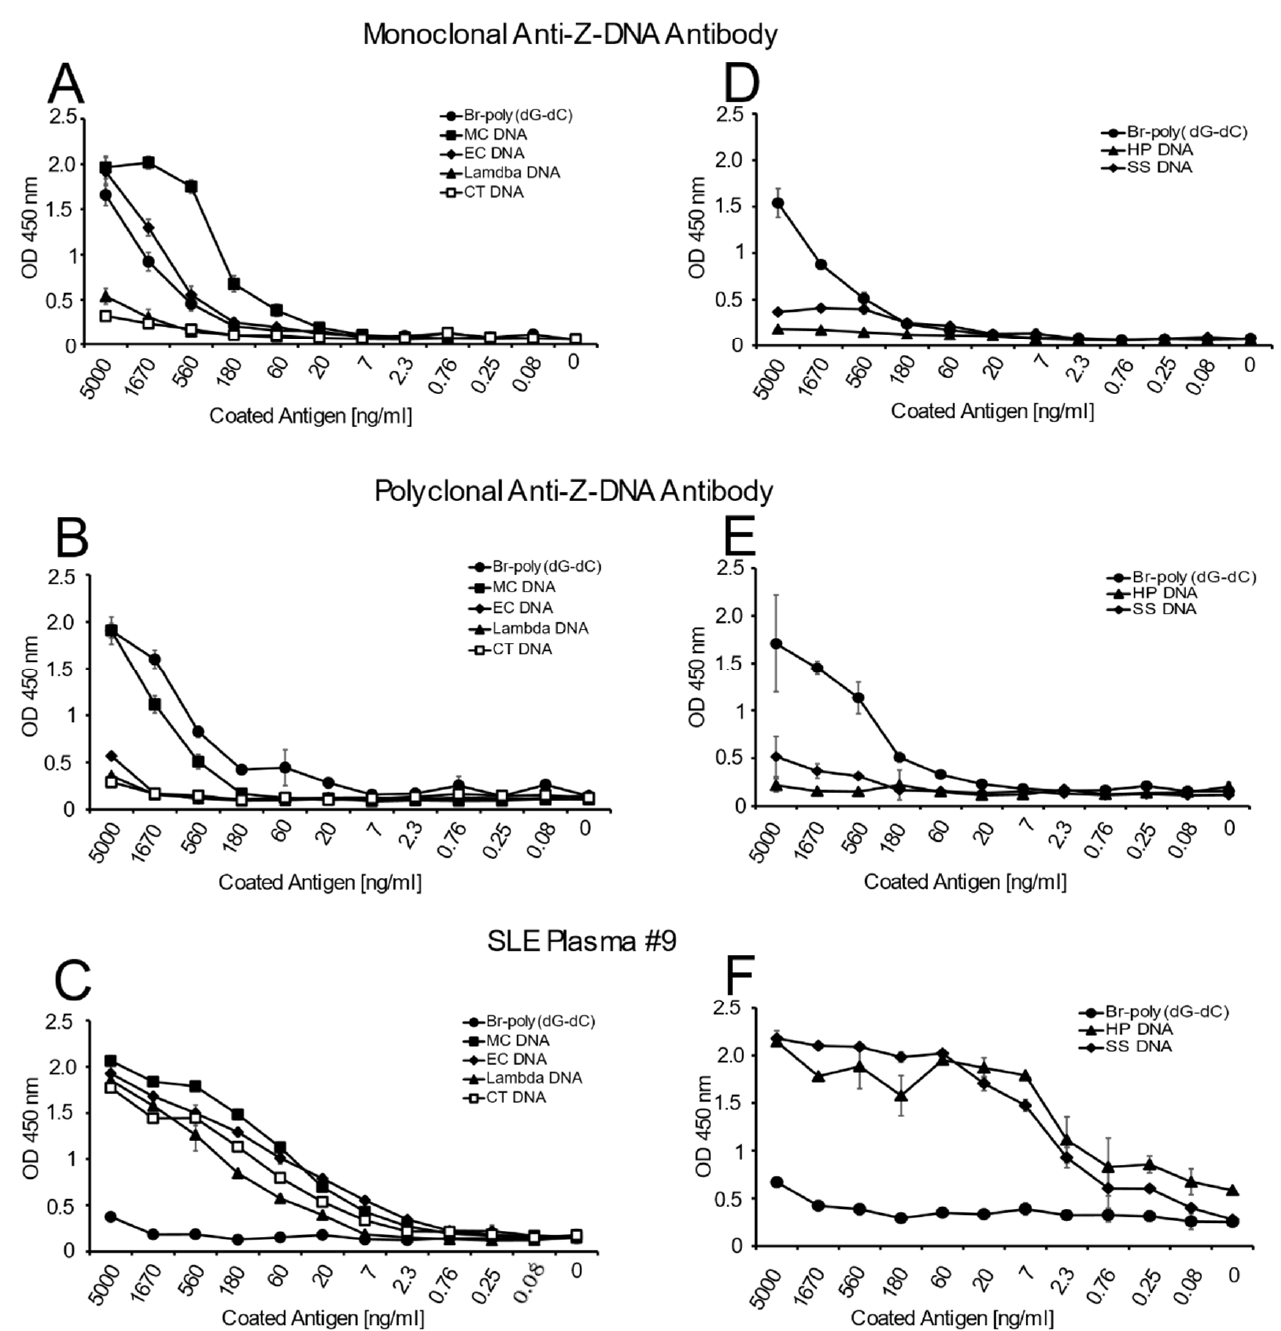
Figure 1. The binding of monoclonal and polyclonal anti-Z-DNA antibodies to natural DNA coated at various concentrations. The binding of either a murine monoclonal anti-Z-DNA antibody ( A , D ); 1:1500 dilution), a sheep polyclonal anti-Z-DNA antibody (( B , E ); 1:1500 dilution) or SLE plasma #9 (( C , F ); 1:1000 dilution)) to various concentrations of DNA coated to microtiter plates was determined by ELISA. Brominated poly (dG-dC) (Br-poly(dG-dC)) was used as a positive control and unbrominated poly (dG-dC) was used as a negative control. Results are reported as OD 450 nm values. All treatments were performed in duplicate. Means and standard deviations are shown.